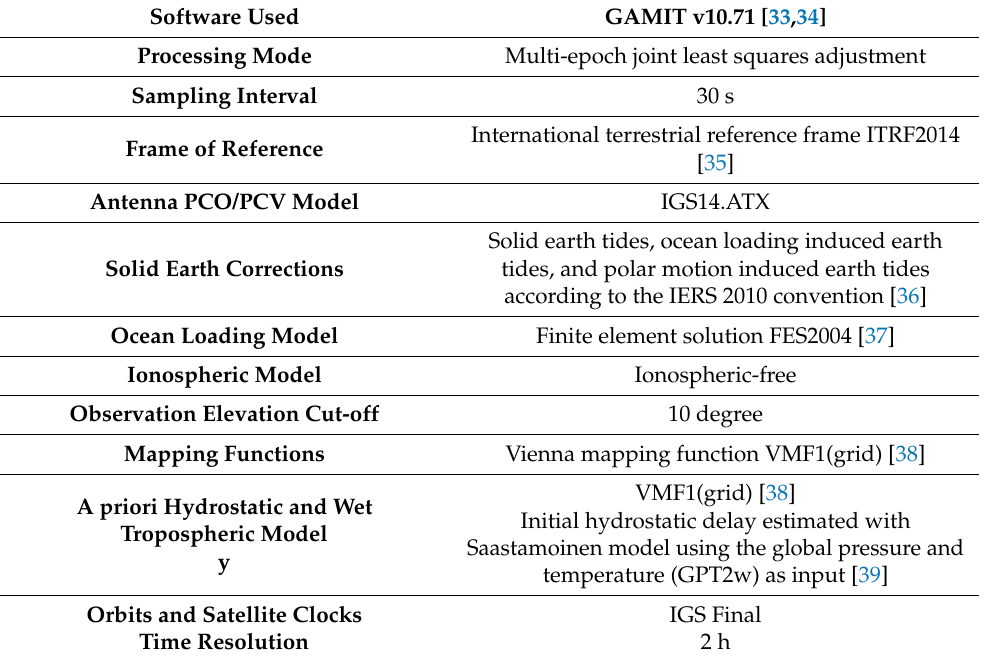
Table 2. GPS data processing